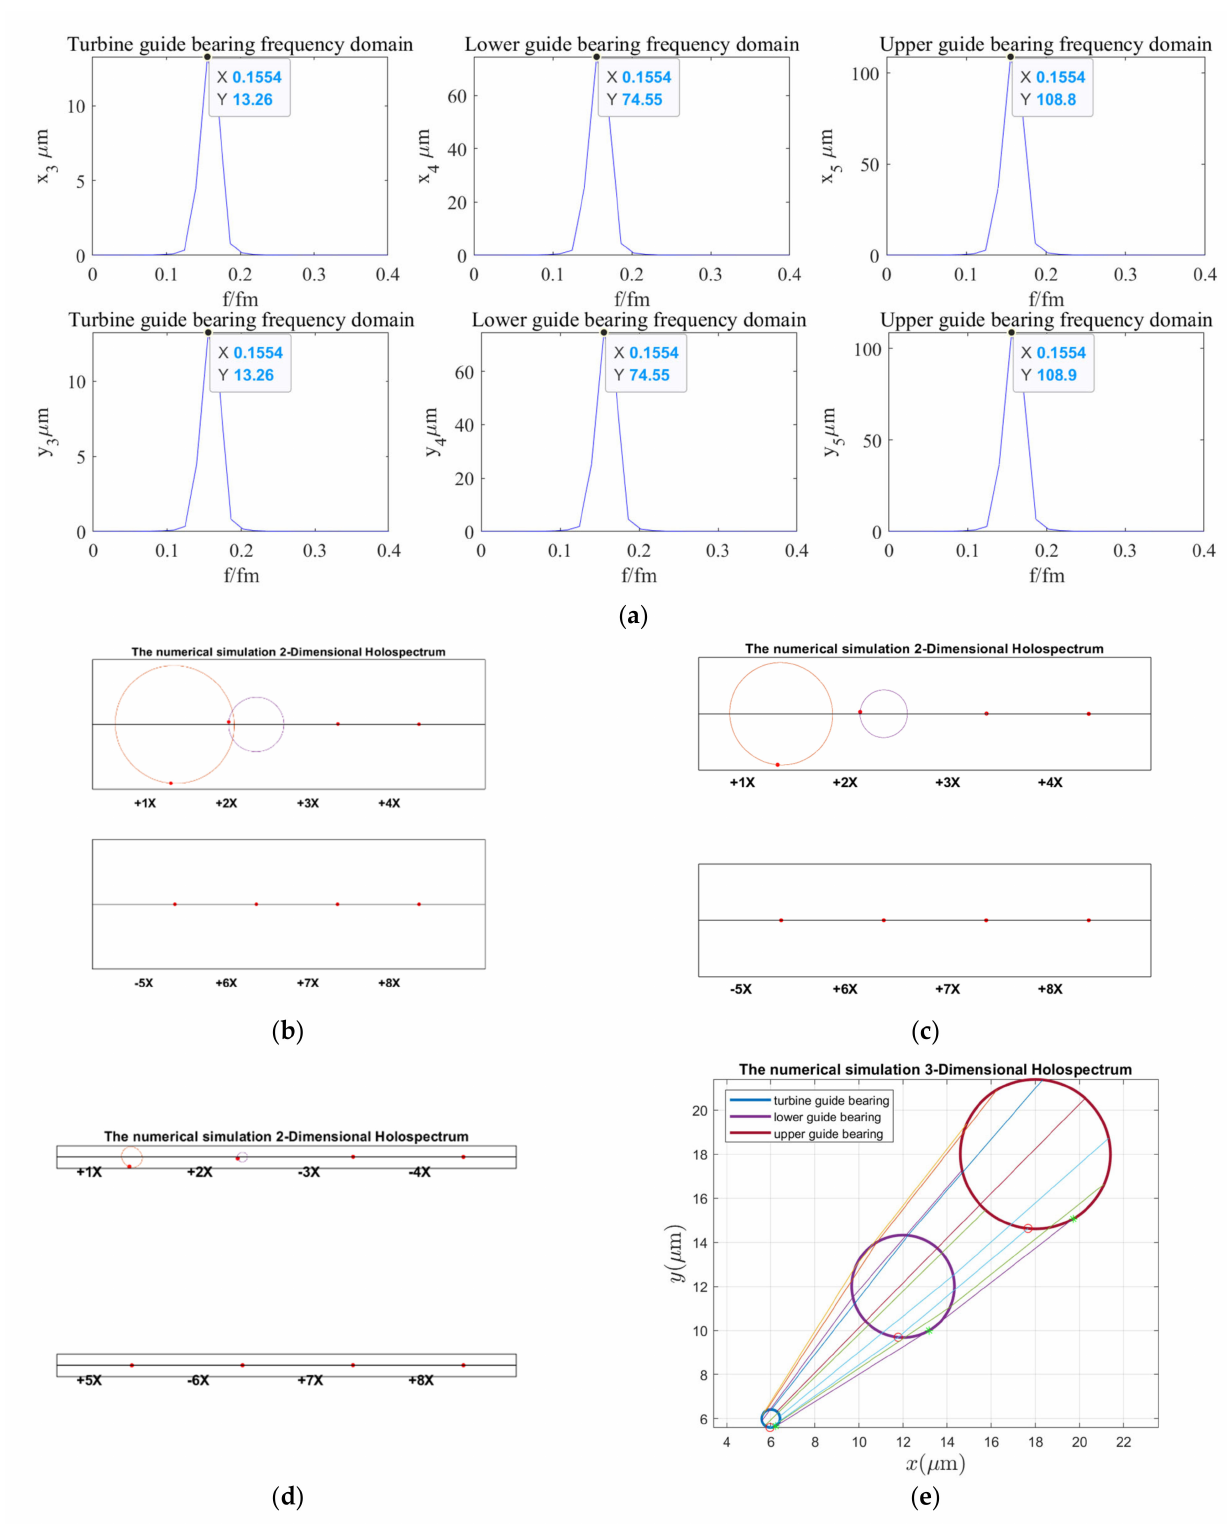
Figure 12. Holospectrum of shafting vibration of unbalance rotor: ( a ) Shafting vibration spectrogram, ( b ) Upper guide bearing 2D holospectrum, ( c ) Lower guide bearing 2D holospectrum, ( d ) Hydro- turbine guide bearing 2D holospectrum, ( e ) One-fold frequency 3D